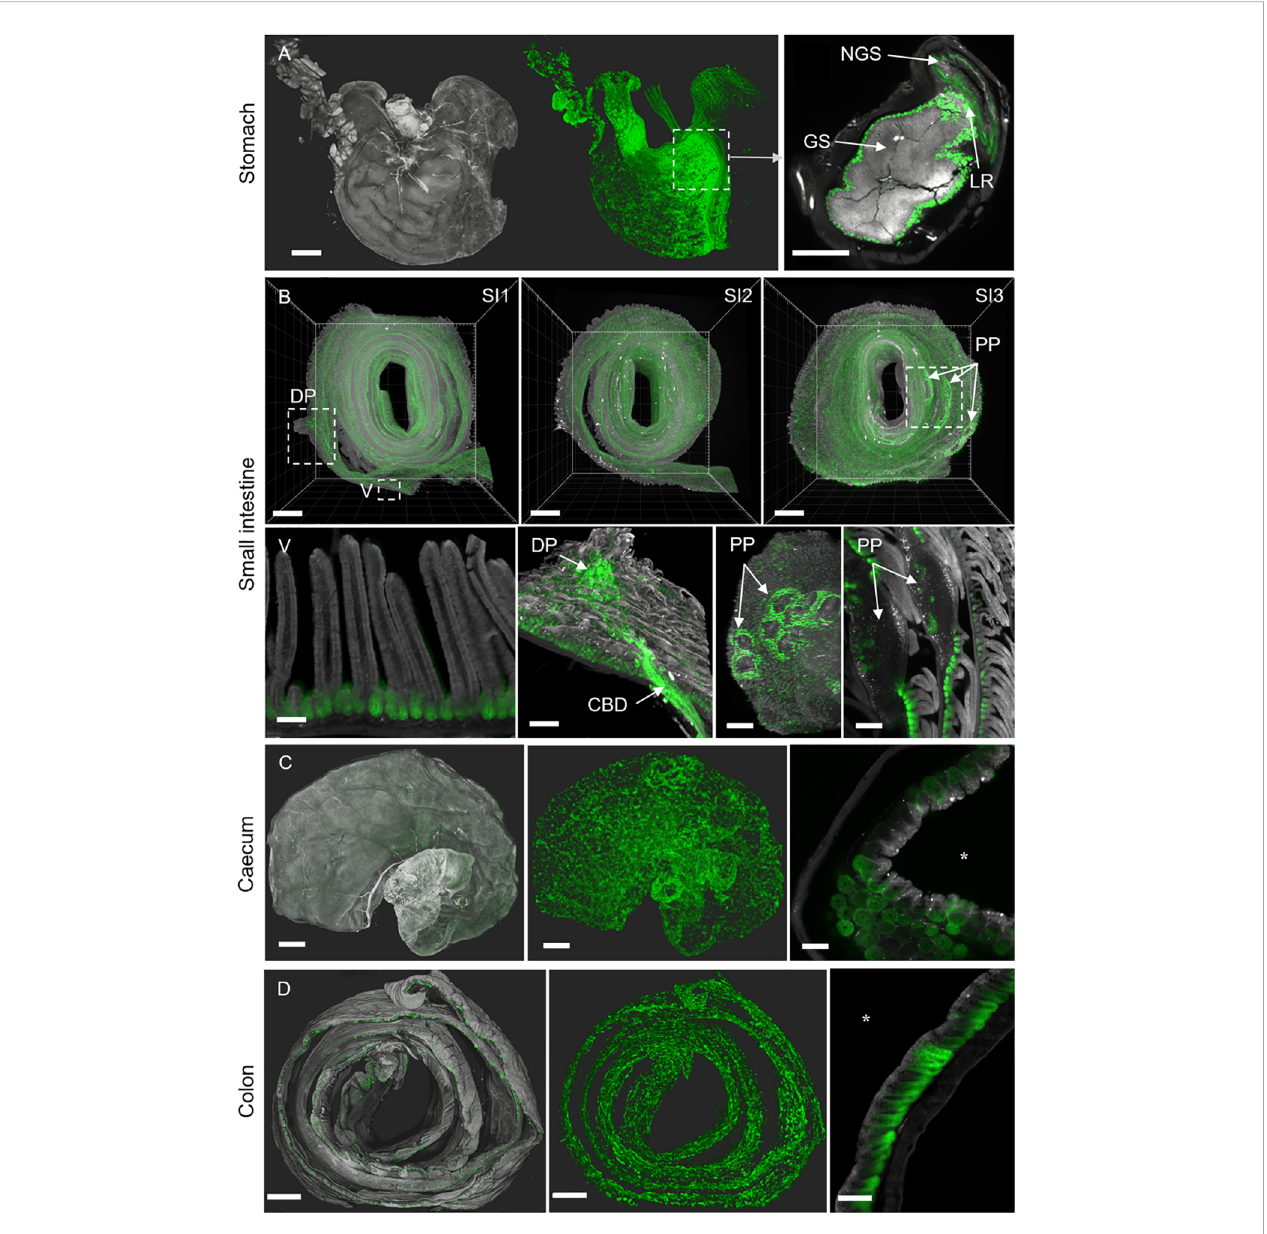
FIGURE 5 3D-Swiss Rolls present anti-EpCAM staining (G8.8R) in the GIT. Tissue auto fl uorescence (grey) and anti-EpCAM staining (G8.8R in green). (A) Surface renderings of the stomach and associated tissues. Left image depicts tissue anatomy, middle image depicts anti-EpCAM staining (G8.8R) antibody in the same specimen without anatomical context. Right image shows junction of the glandular (GS) and non-glandular stomach (NGS) with increased binding to the glandular mucosa near the limiting ridge (LR) (B) All three segments (SI1-3) of the small intestine as 3D-Swiss Rolls (upper row) with indicated duodenal papilla (DP) and several PPs) exposing increased anti-EpCAM binding. Lower row shows higher magni fi cations of structures as indicated in (B) Binding was restricted to basolateral membranes of epithelial cells with pronounced binding to the crypts and decreased or no binding in the villi (V). Anti-EpCAM binding was increased in crypts of the major duodenal papilla, common bile duct (CBD) and near PP compared to overall binding levels in the small intestine. Signals within PP follicles were diffuse and non-membranous, as observed for other lymphoid organs (Suppl. Figures 6-9). (C) Caecum and (D) colon show similar patchy binding patterns with decreasing gradients from the proliferative bottom of the crypts towards the luminal surface of the tissues (luminal domain indicated by *asterisk). Scale bars = 1 mm ( A , B SI1-3, C , D ) and 100 m m (all